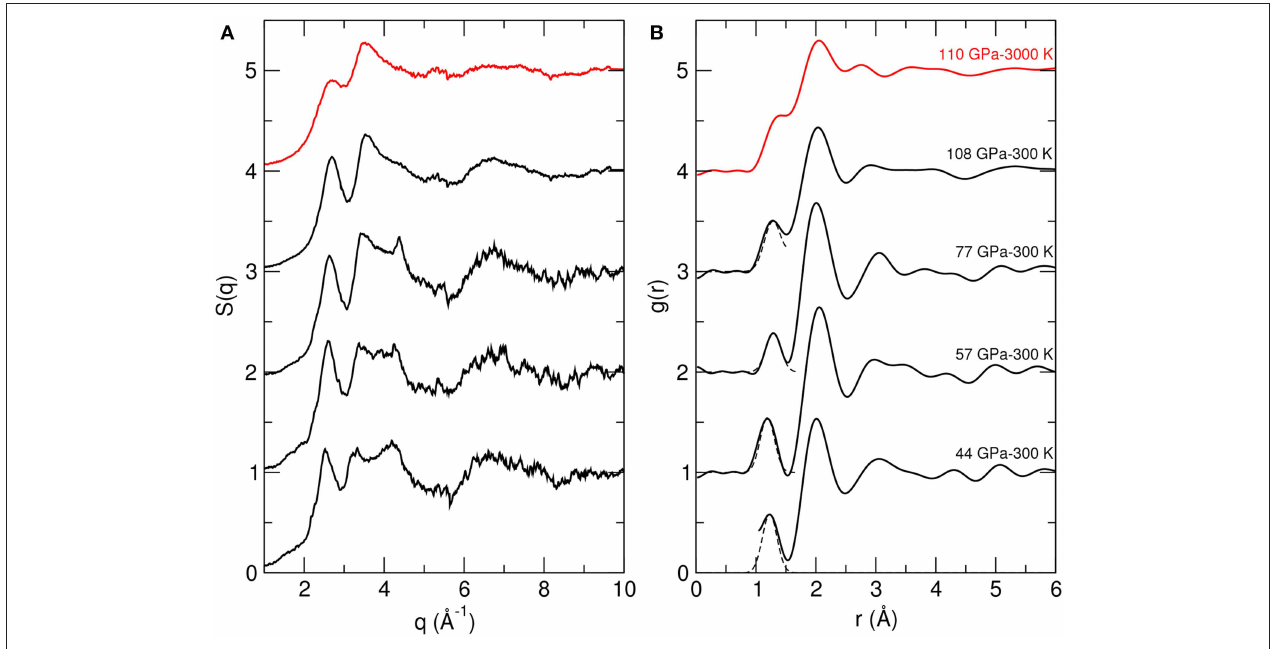
FIGURE 3 | Structure of non-crystalline FeCO 3 at high pressures. (A) Structure factor, S ( q ), for all quenched glasses (black) and the highest P melt (red). (B) Corresponding radial distribution functions, g ( r ). Dashed lines are fits to the C-O contribution at 1.2-1.3 Å where there is no overlap with farther contributions.